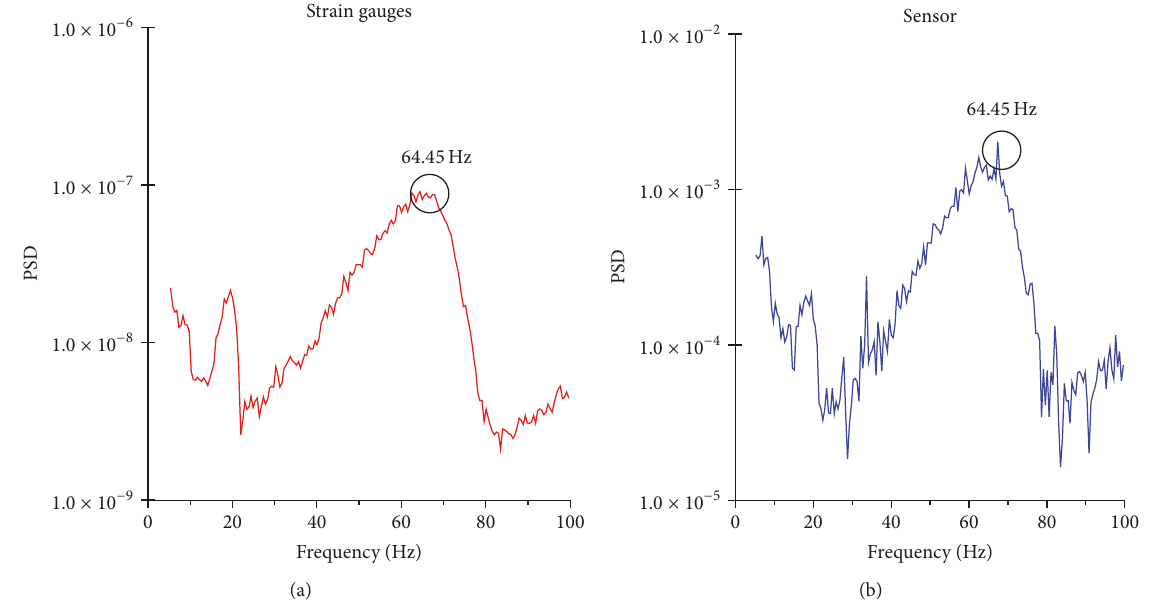
Figure 14: PSD of strain gauges measurements (a) and of electrical measurements (b) from the embedded sample placed at